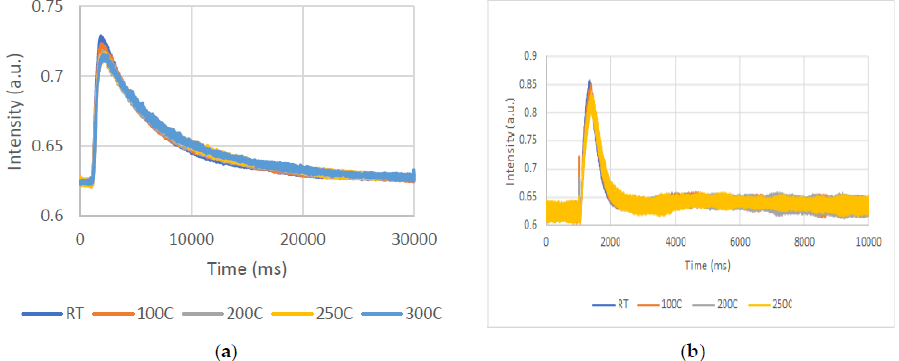
Figure 10. Oxygen response to: ( a )–oxygen pulses and ( b )–to oxygen:acetone/Ar pulses over the 5 mg catalyst.